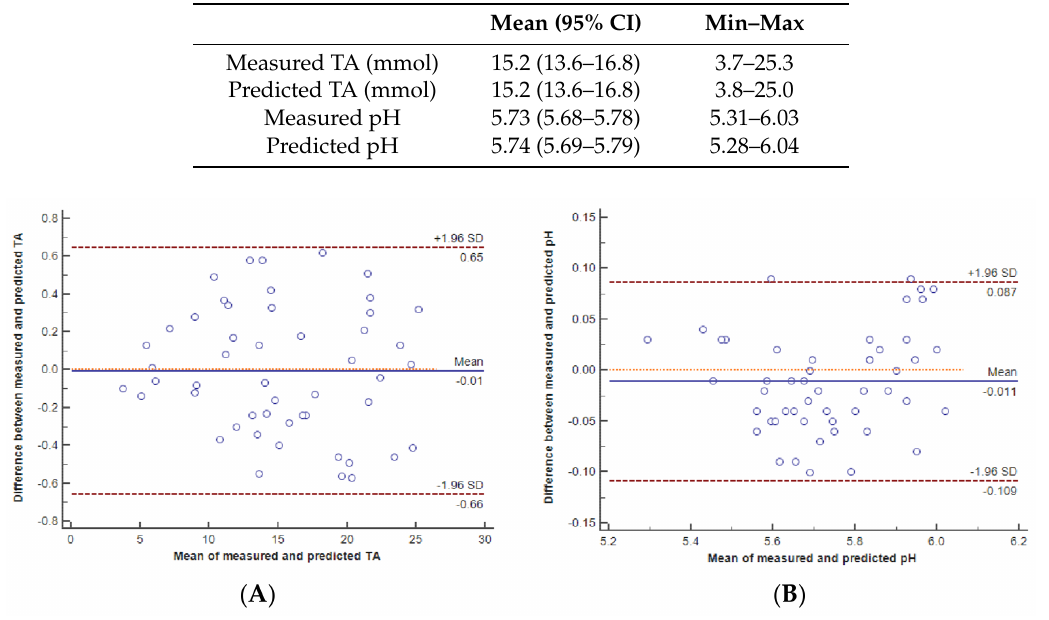
Figure 2. Bland-Altman plots for the measured and predicted values of titratable acidity (TA), ( A ) and pH ( B ).